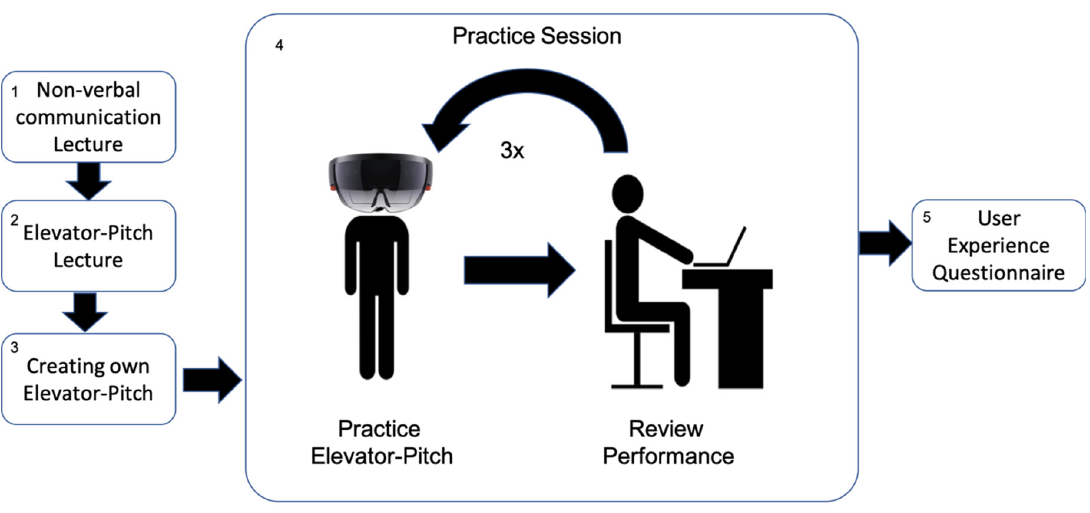
Figure 4. User test procedure.